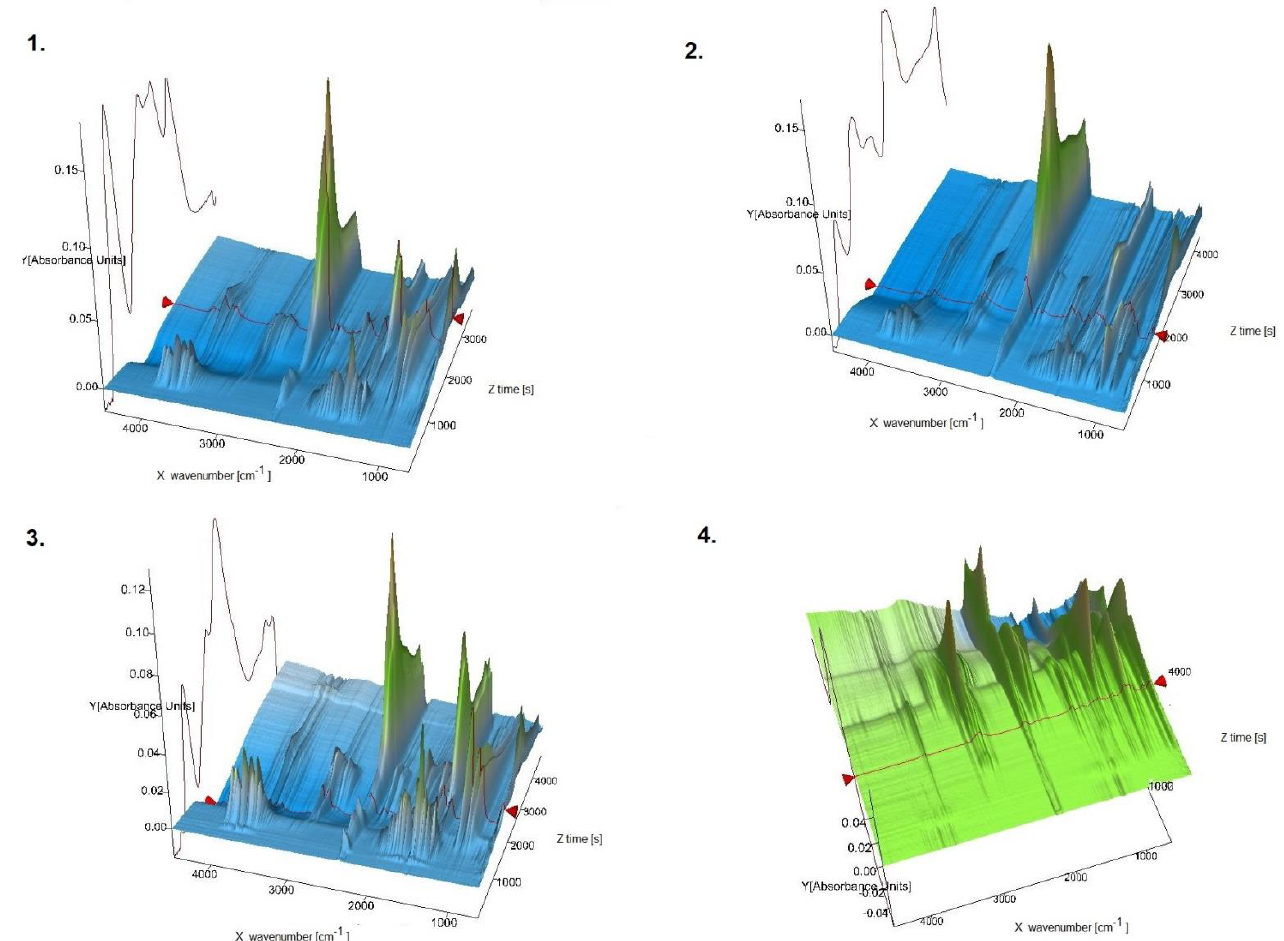
Figure 5. TG-FTIR spectra (3D) for 1—oligomers of 3-buten-1-ol; 2—oligomers of 2-chloro-2-propen-1-ol; 3—oligomers of allyl alcohol; 4—oligomers of 2,3-dibromo-2-propen-1-ol.